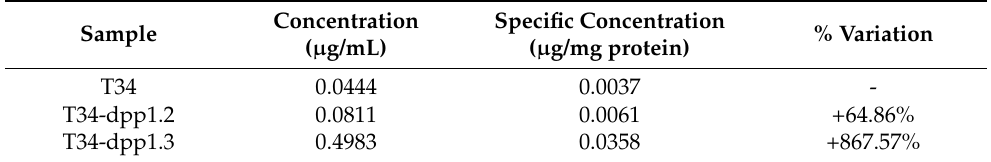
Figure 4. HPLC chromatograms showing levels of farnesol detected in mycelia of strains T34-43b.1 ( upper panel ), T34-dpp1.2 ( middle panel ) and T34-dpp1.3 ( bottom panel ). Farnesol levels were deduced from the area of the farnesol peak using a calibration curve performed with multiple known concentrations of pure farnesol. Table 1. Quantification of farnesol from 24 h culture